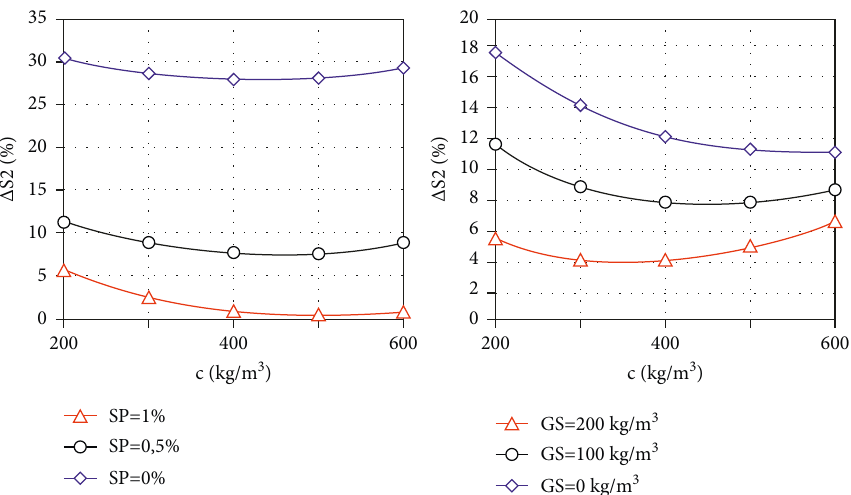
Figure 4: Dependence of SCC mix workability retention at 2 hours ( Δ S2, %) on cement